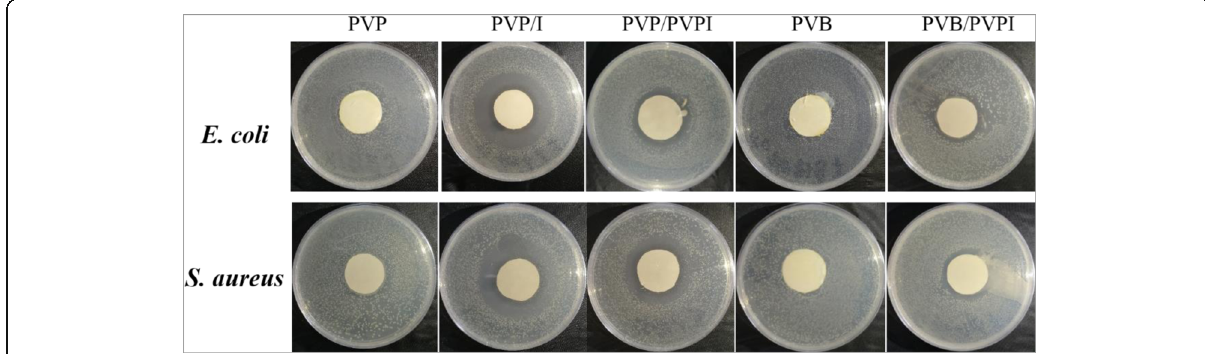
Fig. 6 The antibacterial activity of the as-spun membranes against E. coli and S. aureus